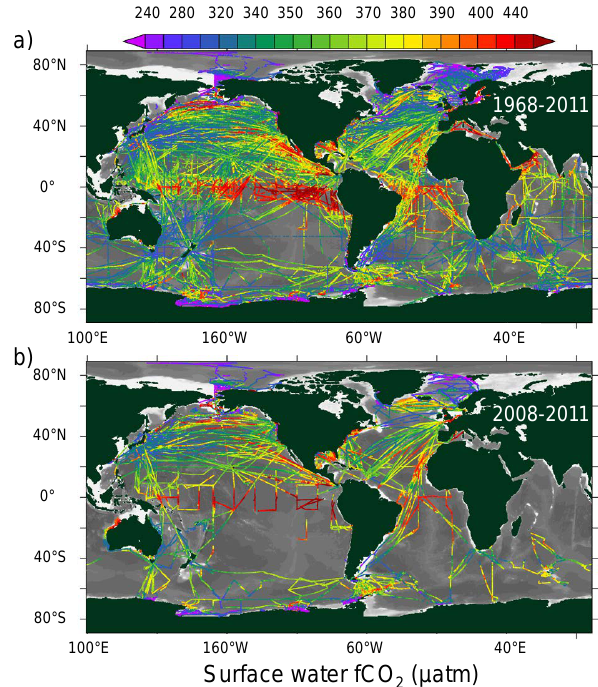
Figure 2. The global distribution of surface water f CO 2 values in SOCAT version 2: (a) for 1968 to 2011 and (b) for 2008 to